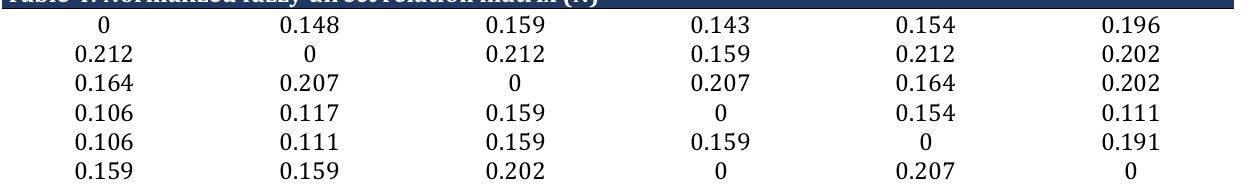
Table 4: Normalized fuzzy direct relation matrix (N)